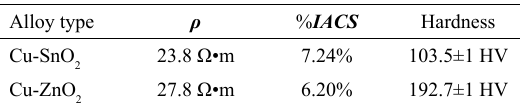
Table 1. Physical properties parameters of both type Cu-based contact materials. Alloy